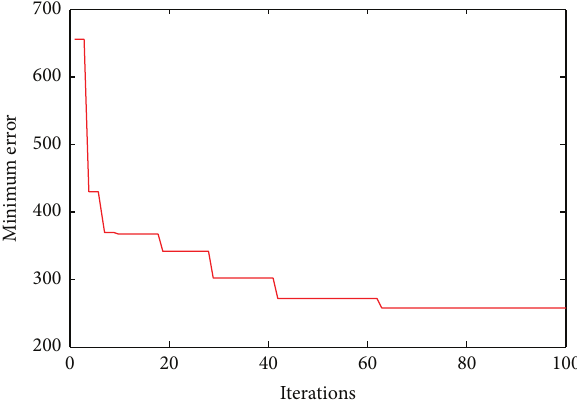
Figure 6: The minimum error evolution of PSO-RBF neural